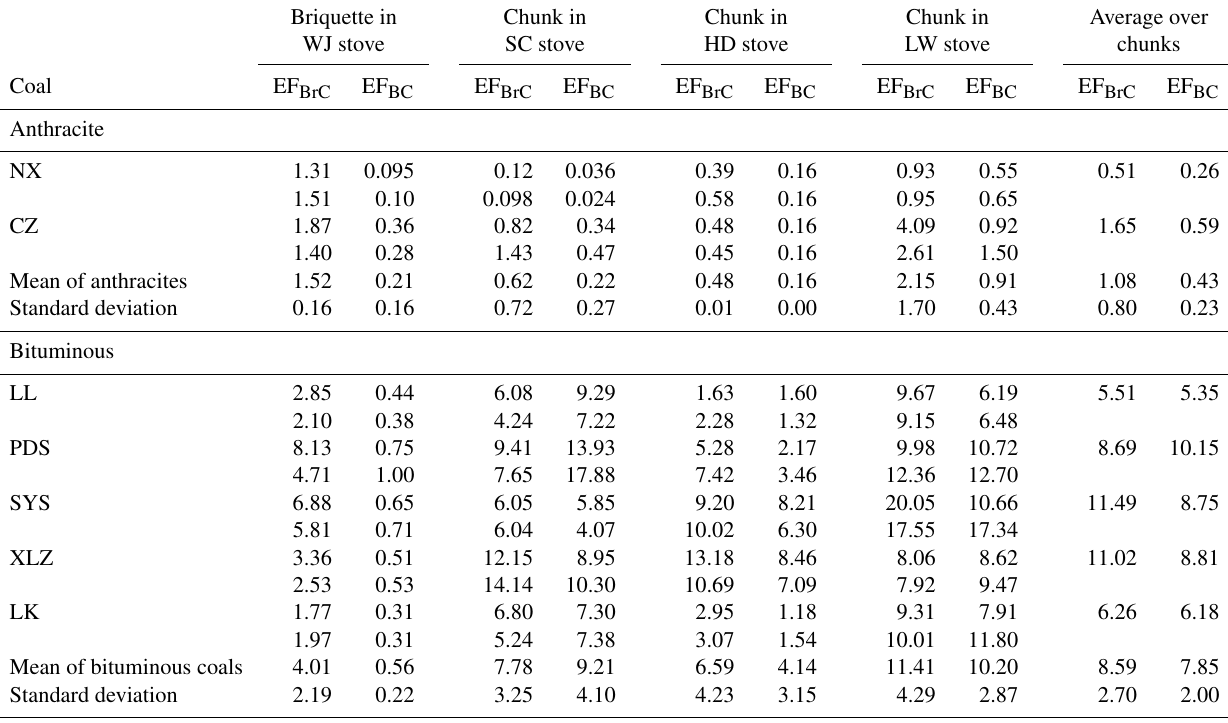
Table 2. Measured emission factors (gkg − 1 ) of BrC and BC for China’s household coal combustion. Briquette in Chunk in Chunk in Chunk in Average over WJ stove SC stove HD stove LW stove chunks